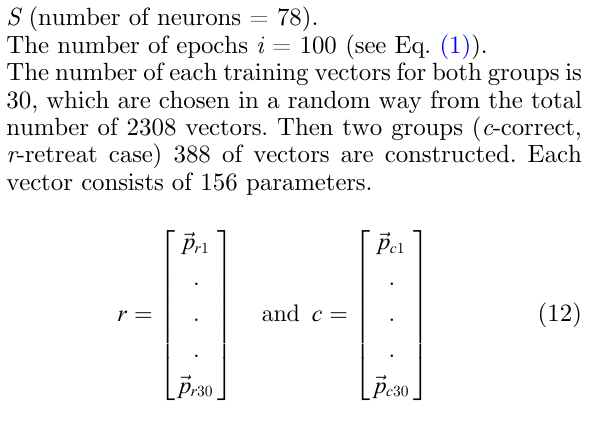
following characteristics according to section Refractive